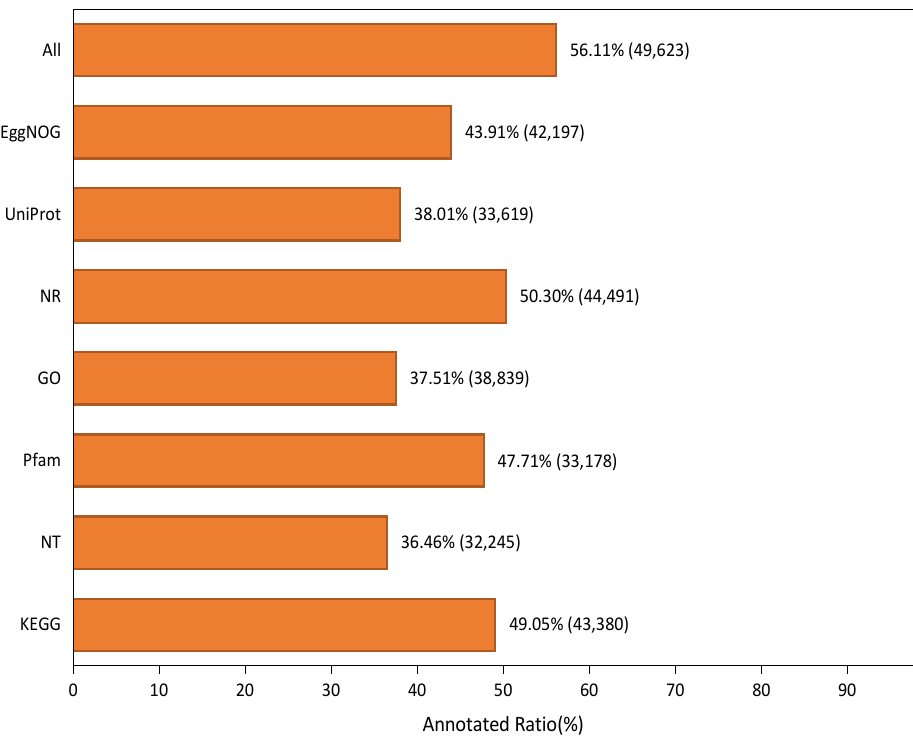
Figure 1. Annotated result of A. pusilla leaf transcriptome using various